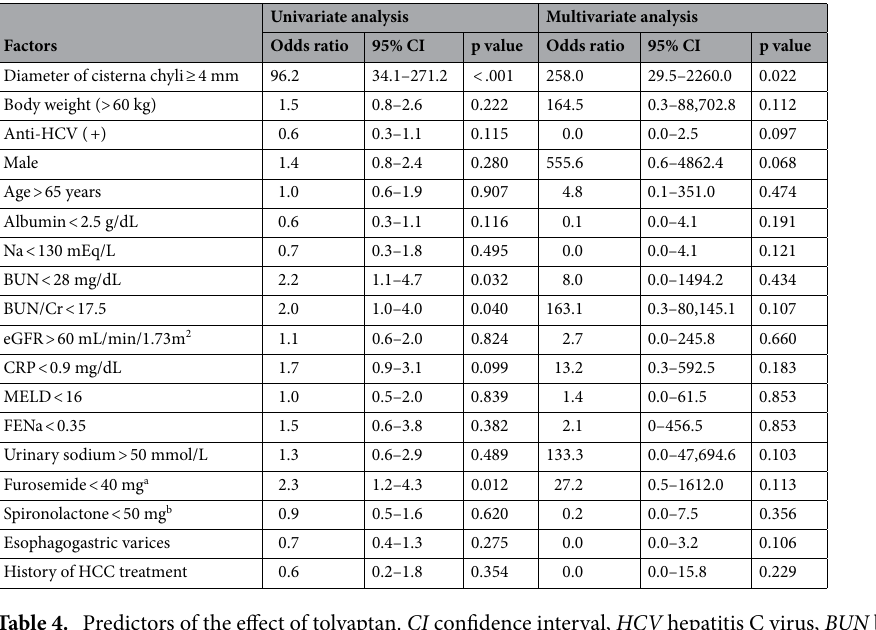
Table 4. Predictors of the effect of tolvaptan. CI confidence interval, HCV hepatitis C virus, BUN blood urea nitrogen, BUN/Cr blood urea nitrogen/creatinine, CRP c-reactive protein, MELD model for end-stage liver disease, FENa fractional excretion of sodium, HCC hepatocellular carcinoma. a Dose of furosemide during tolvaptan treatment. b Dose of spironolactone during tolvaptan